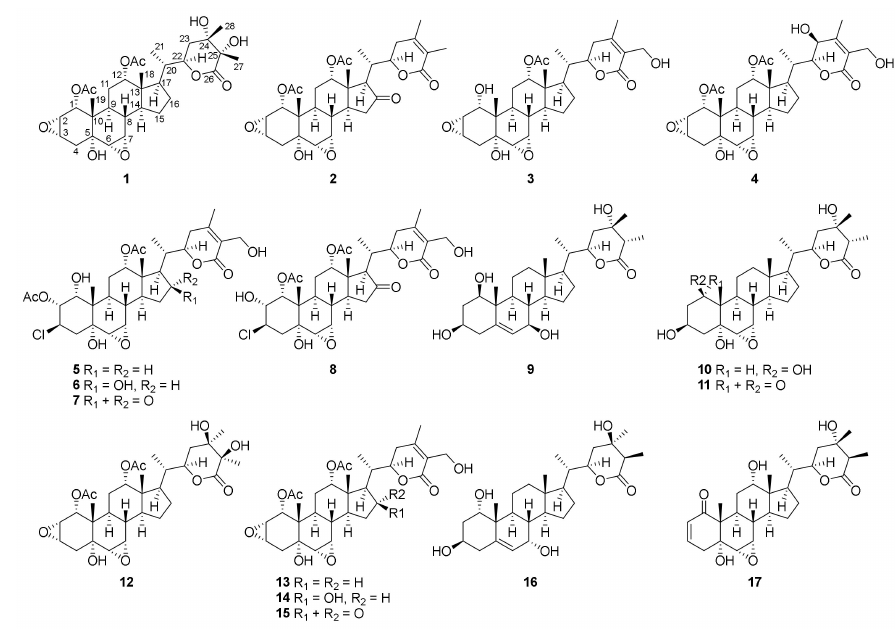
Figure 1. Structures of compounds 1 – 17 from Taccaceae chantrieri